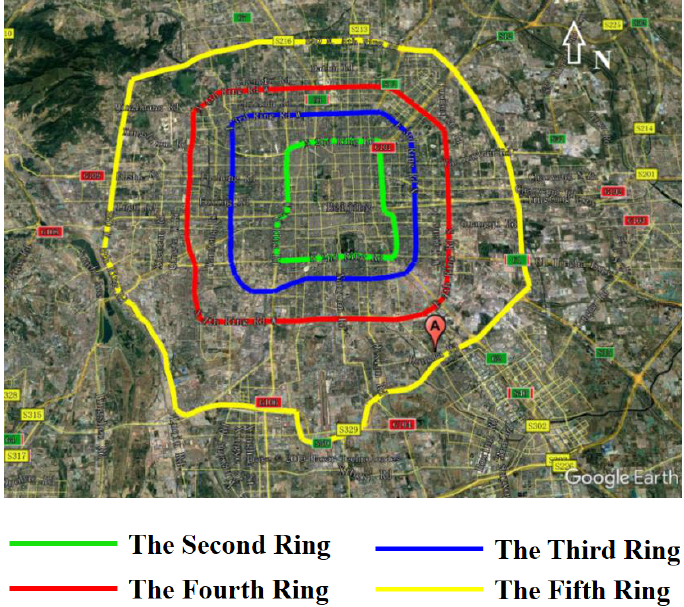
Figure 2. The ring roads of Beijing, China. Map data © Google Earth (point A is the location of the wind profile radar).